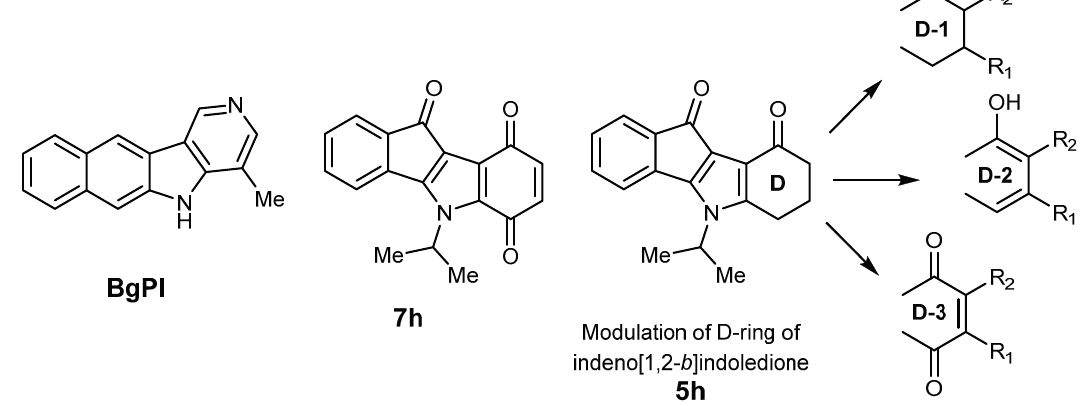
Figure 1. Examples of known CK2 inhibitors.